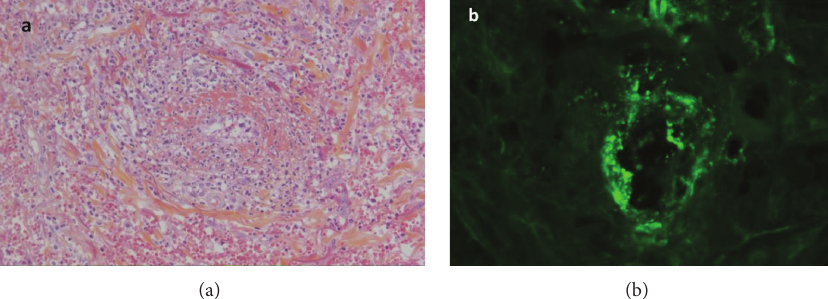
Figure 1: Skin biopsies of vasculitis lesions in lower limbs of the patient with refractory HSP (punch biopsy, 4 mm) were performed for routine histopathology and direct immunofluorescence. (a) Leukocytoclastic vasculitis: fibrin necrosis and infiltration of the blood vessel by neutrophils and conspicuous nuclear dust. Numerous extravasated blood cells (HES × 200). (b) IgA deposits in and around the vessel wall (direct immunofluorescence × 800).